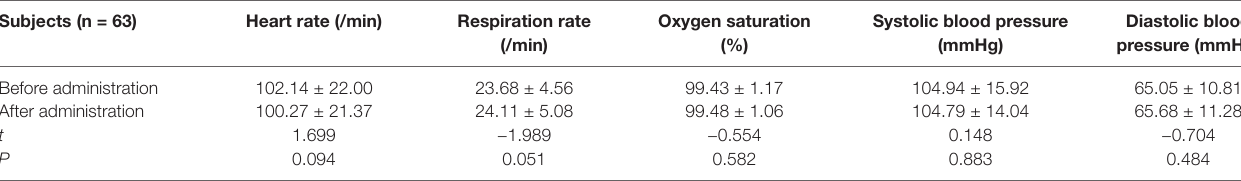
TABlE 3 | The vital signs of the awake participants.